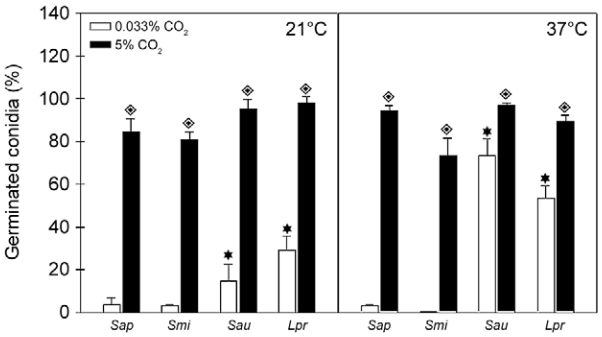
: evaluation of conidial germination of Scedosporium apiospermum (Sap), S. minutisporum (Smi), S. aurantiacum (Sau) and Lomentospora prolificans (Lpr) in different temperatures and CO2 tensions. Conidial cells were incubated for 4 h on Sabouraud medium at 21ºC and 37ºC in an atmosphere of 5% CO2 or 0.033% CO2. After incubation, fungal cells were counted by using an inverted microscope. The results are shown as the mean ± standard deviation of three independent experiments. Diamonds represent the significant difference (p < 0.05, Student’s t test) when the germination of each fungus was compared under different CO2 tensions (5% or 0.033% CO2), while stars represent the significant difference (p < 0.05, Student’s t test) when the germination of each fungus was compared under different temperatures (21ºC and 37ºC).